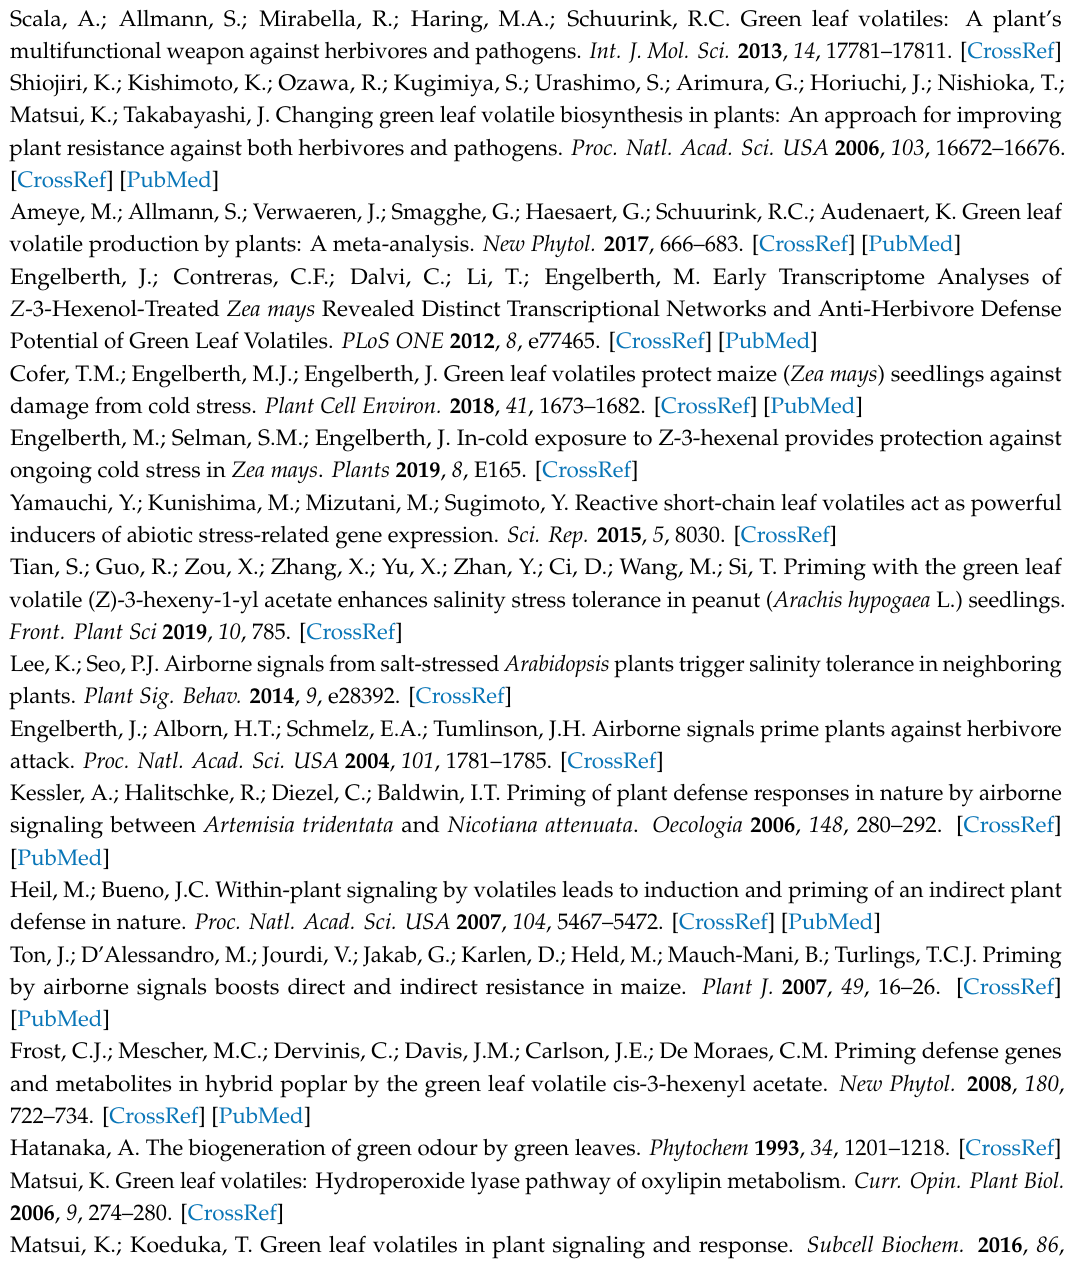
Table S1: Green leaf volatile release by di ff erent plant species; Figure S1: Systematic analysis of green leaf volatile